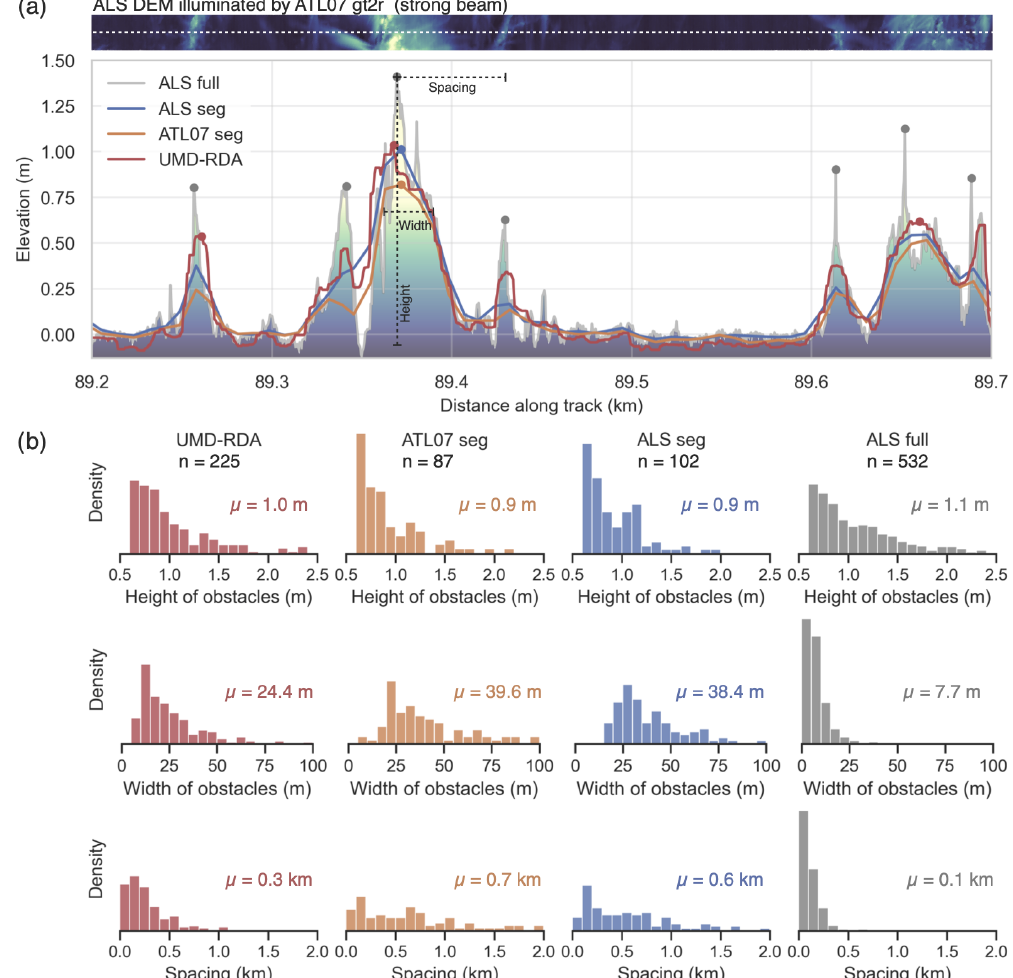
Figure 9. (a) The 500m profile section along strong beam gt2r with sea ice elevations of different height products. Filled circles highlight peaks that exceed a height of 0.6m with reference to the modal elevation of the entire track. The contour in the background shows the actual topography from airborne laser scanner (ALS) data along the center line of the ALS gridded segments shown at the top, corresponding to the ATL07 segment area. (b) Distributions of properties of n detected peaks ( > 0.6m) along the entire helicopter profile: heights and widths of obstacles as well as spacing between obstacles. µ represents the mean value for each